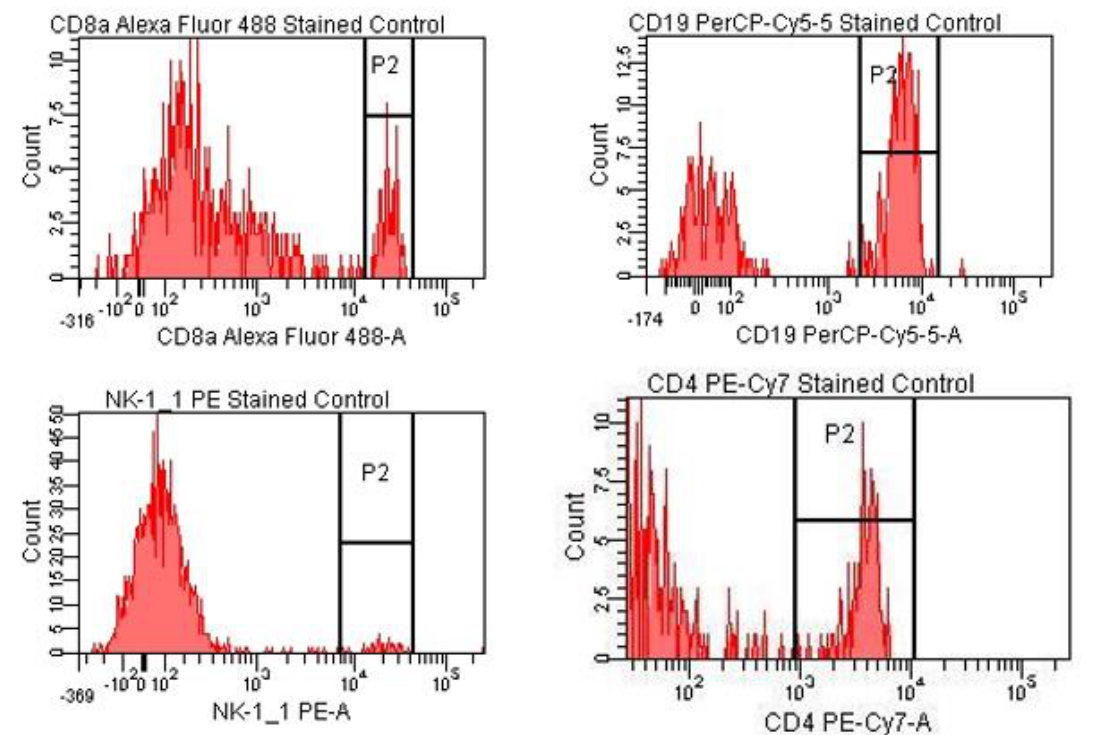
Figure 4. Labeled cell suspension—blue laser stimulation.